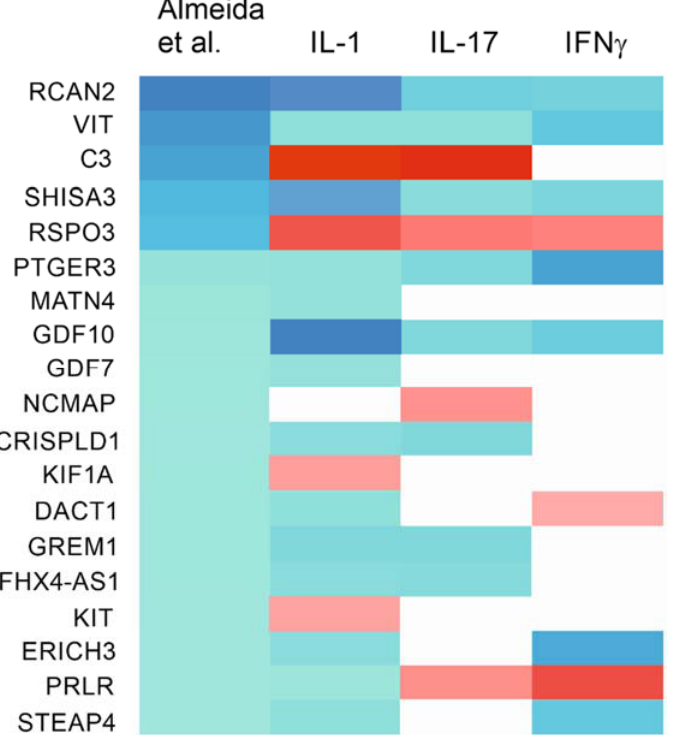
Figure 3. Heatmap of genes markedly downregulated (FC < − 2.5) in degraded cartilage in the study by Almeida et al. [35] and significantly affected by at least one studied proinflammatory cytokine. Upregulated genes are marked with red, downregulated with blue, and genes with no significant fold change with white .